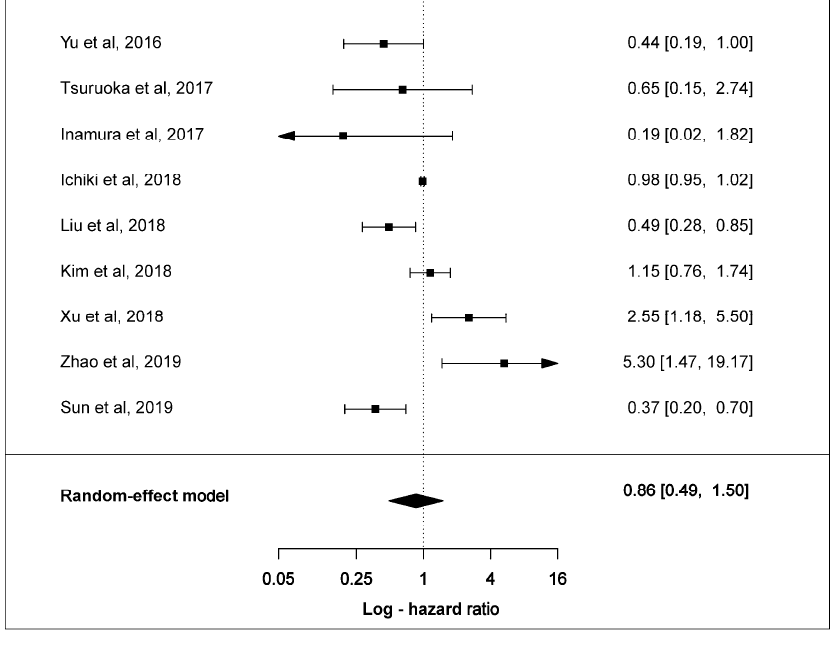
Figure 7. Forest plots of overall survival and PD-L1 expression in SCLC tumours. The HR and 95% CI of each study is represented with a horizontal line and the square area mirrors the size e ff ect of each study. Pooled HR and 95% CI are depicted by diamonds. A random-e ff ect model was